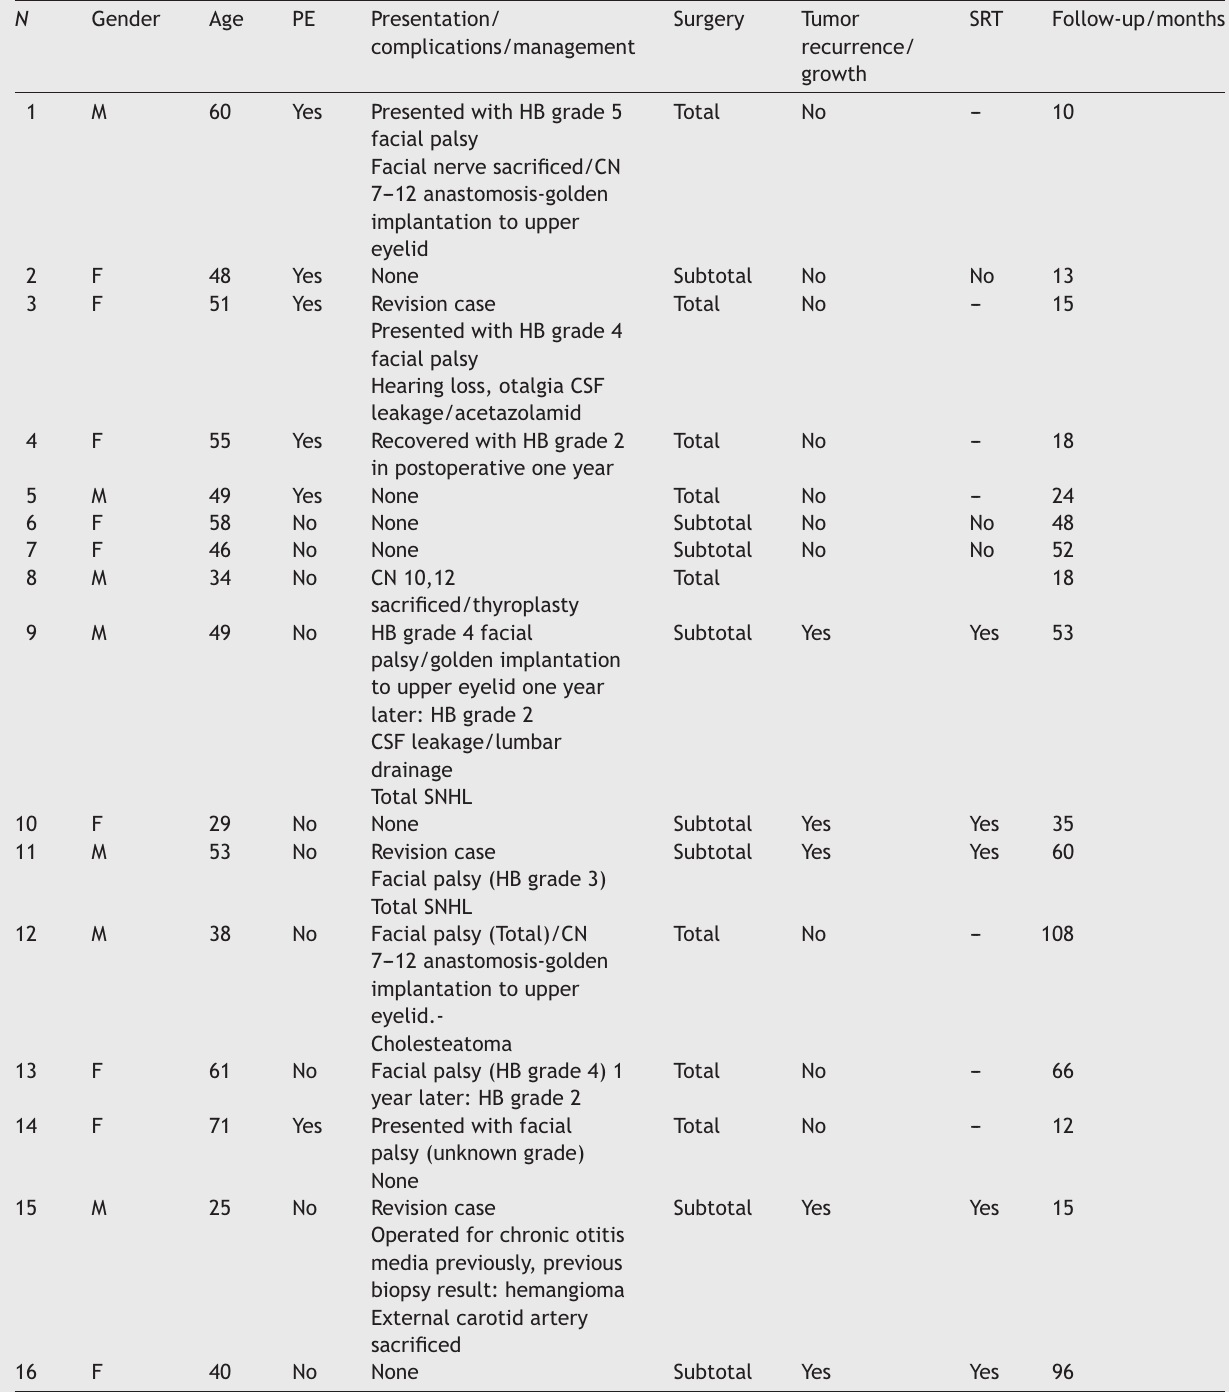
Table 4 Detailed information of patients with